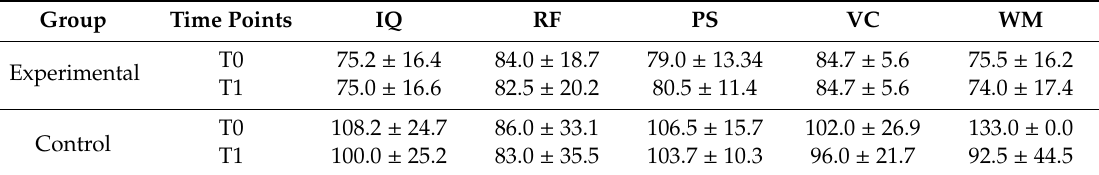
Table 6. Statistical results of the WISC tests at baseline and the end of the reading sessions ( p > 0.05). Mean ± Standard Deviation is reported.